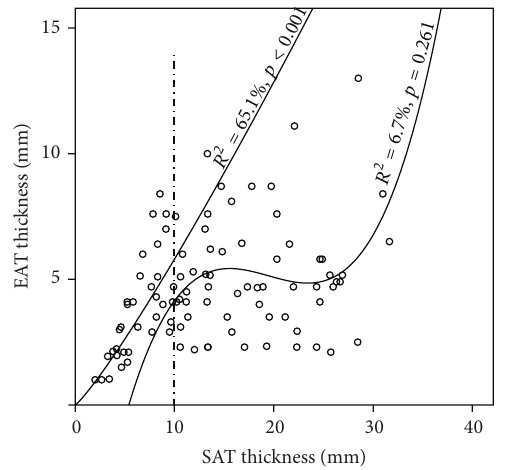
Figure 2: Nonlinear power curve relationship of EAT thickness and SAT thinner than